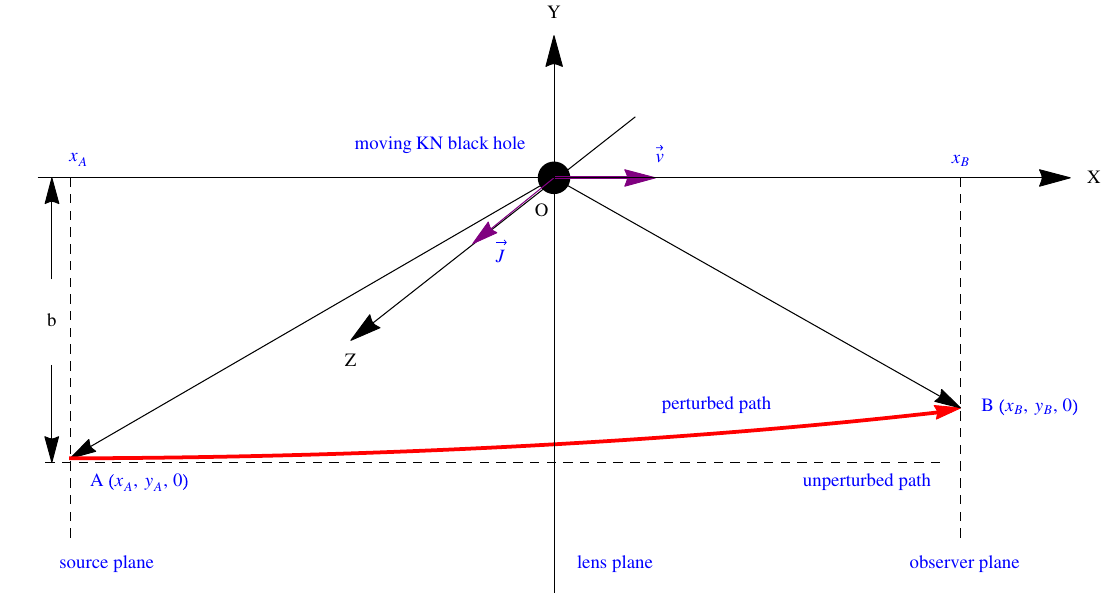
deflection is greatly exaggerated to distinguish the light path (red line) from the unperturbed path (dashed horizontal